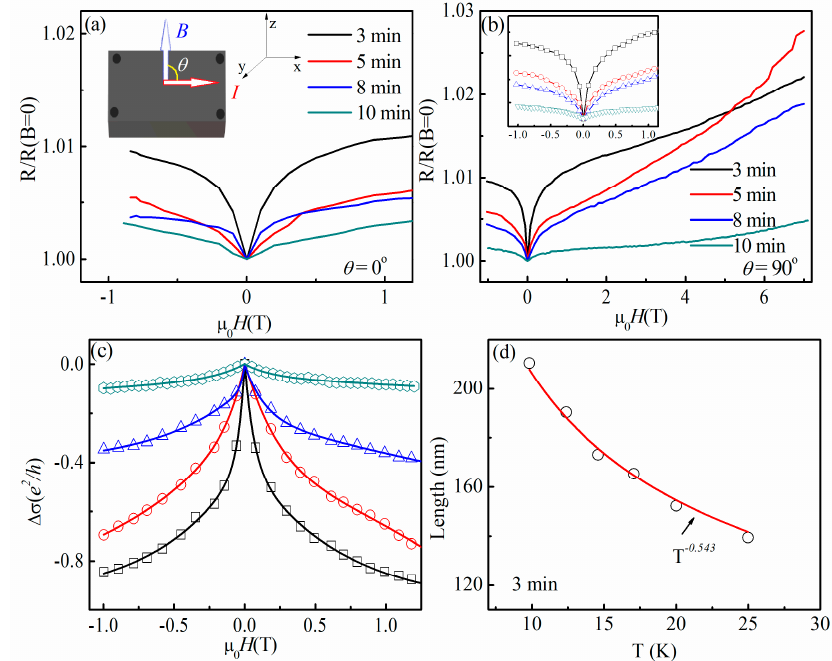
Figure 7. ( a ) Normalized magnetoresistance of Bi 2 Se 3 films on LSMO/LAO of different deposition times measured at θ = 0°, T = 10 K. ( b ) Normalized magnetoresistance of Bi 2 Se 3 films measured at θ = 90°, T = 10 K. Inset: enlarged view of MR near zero fields showing the robustness of the WAL effect. ( c ) The HLN fit of the weak-field magnetoconductivity Δ σ for films with different deposition times measured at T = 10 K after subtracting the 3D bulk contribution; solid curves represent fitting data. ( d ) The relationship between the coherence length of t = 3 min Bi 2 Se 3 film and temperature. The circle represents the experimental results, and the solid curve represents the fitting results.